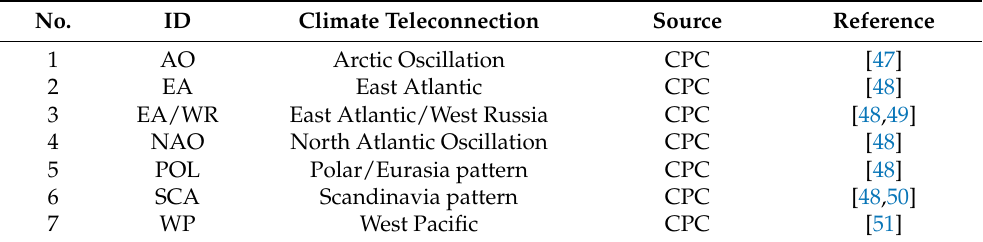
Table 1. Summary of climate teleconnections considered in this